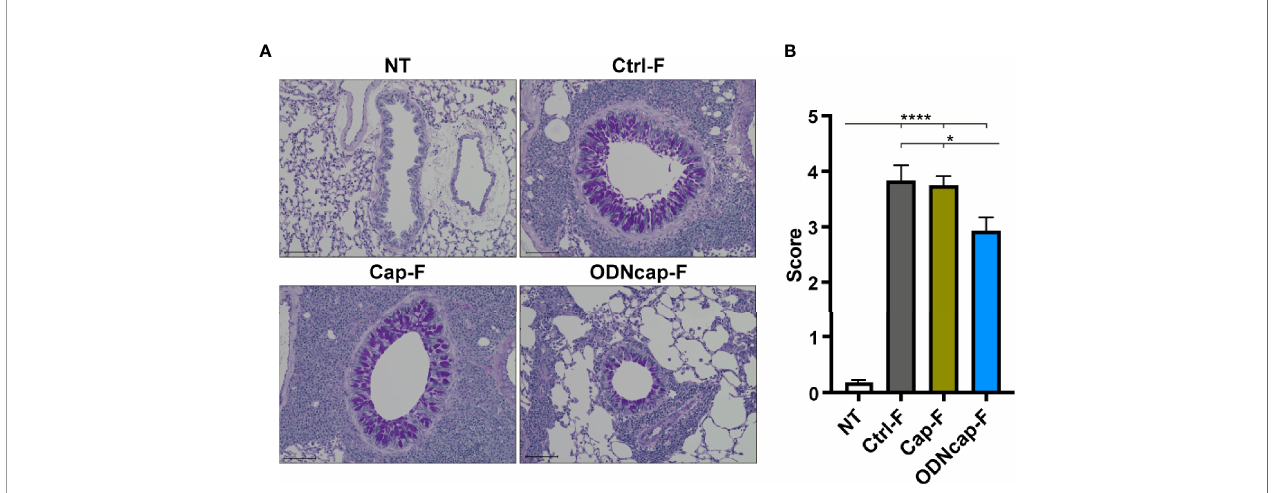
FIGURE 3 | ODNcap-F attenuates bronchial goblet cell hyperplasia. Lung sections were prepared on Day 70. (A) Representative images of periodic acid-Schiff (PAS)-stained sections ( n = 6). Scale bars, 100 m m. (B) The PAS-positive area around the bronchi was scored using the ranking system described in the Materials and Methods ( n = 6). Six to eight bronchi per animal were assessed to obtain the average individual score. Data are shown as the mean ± standard error of the mean. **** P < 0.0001; * P < 0.05 by two-tailed one-way analysis of variance and post hoc Tukey ’ s